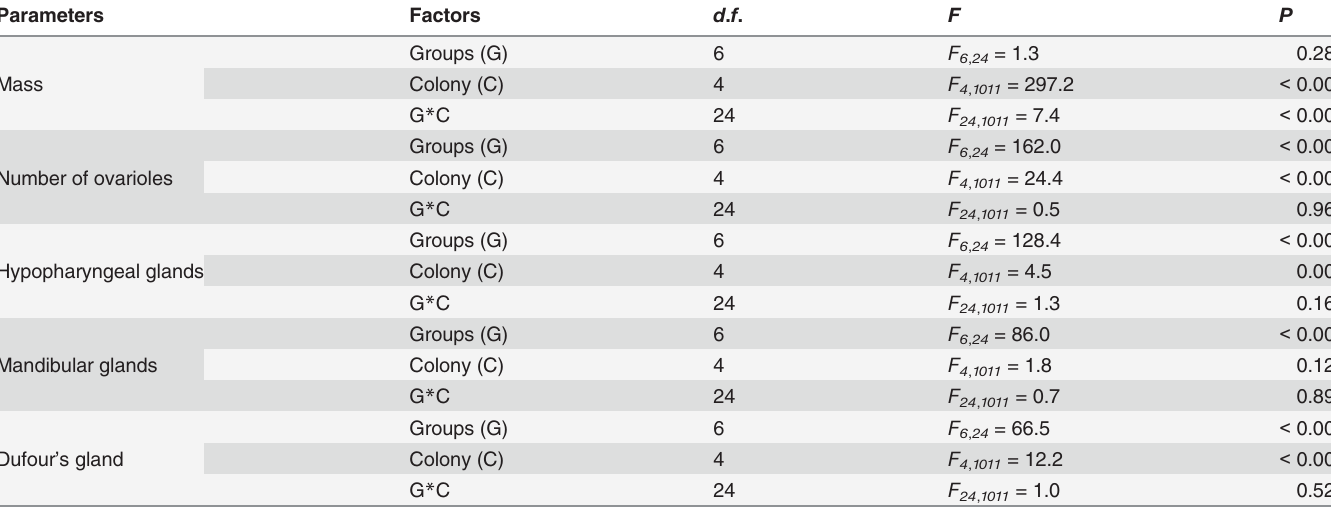
Table 1. Results of mixed model two-way ANOVA for body parameters of newly emerged honeybee workers reared as larvae for 0 to 6 days in the queenless condition (7 experimental groups — fixed factor) and different colonies (random factor).